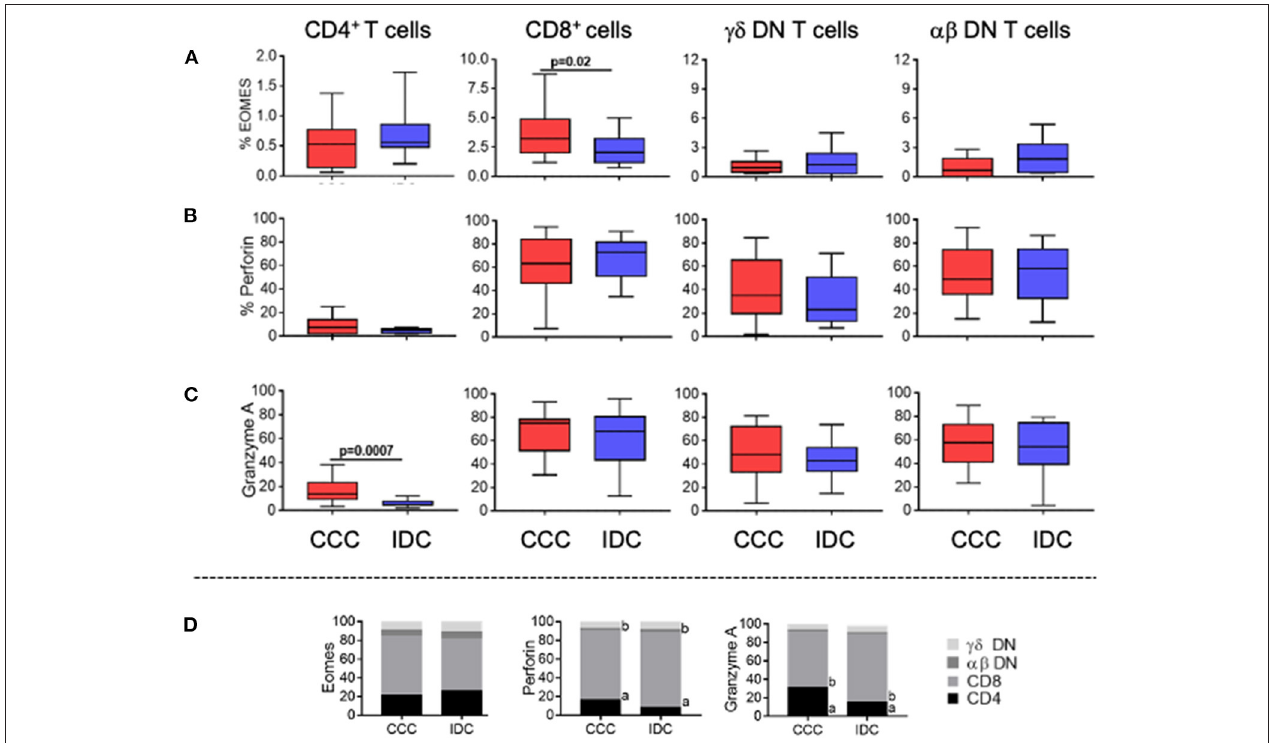
FIGURE 4 | Expression of cytotoxic molecules by the different T-cell subpopulations. Frequency of expression of molecules associated with cytotoxic function (A) Eomes, (B) perforin and (C) granzyme A are shown. Graphs are expressed as boxplots, with the minimum and maximum values indicated. (D) Contribution of different cell subpopulations to the expression of different cytotoxic molecules. The analysis was performed as described in the materials and methods for comparison between the different groups in CD4 + , CD8 + , gamma-delta + DN T cells (CCC, n = 17, IDC, n = 13) and alpha-beta + DN T cells (CCC, n = 10, IDC, n = 10). Values of p < 0.05 were considered statistically